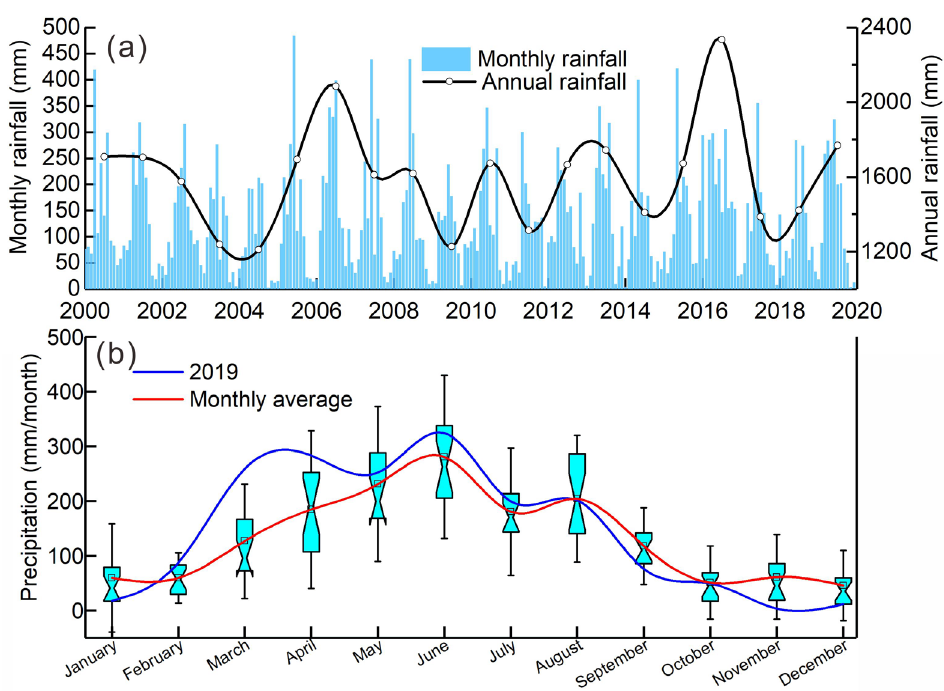
Figure 5. Monthly rainfall data of Longchuan County in the past 20 years from 2000 to 2020; ( a ) monthly and annual average rainfall data over the last 20 years; ( b ) comparing the monthly rainfall in 2019 with the average value over the last two decades.